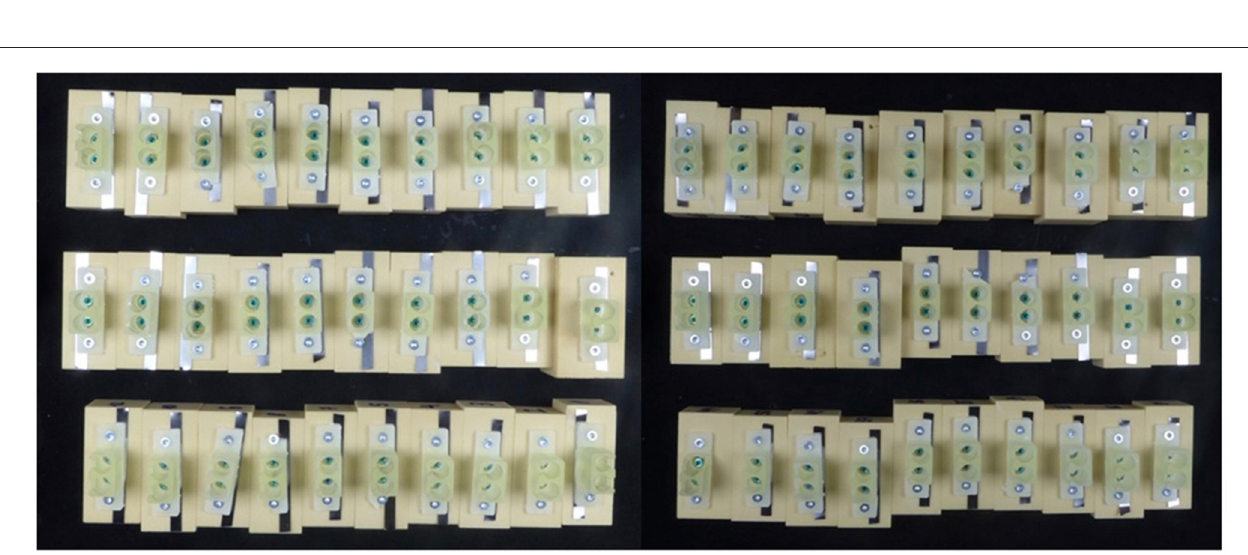
FIGURE 4 | Sixty identical insertion guides were produced and divided into two groups, with 30 insertion guides each.